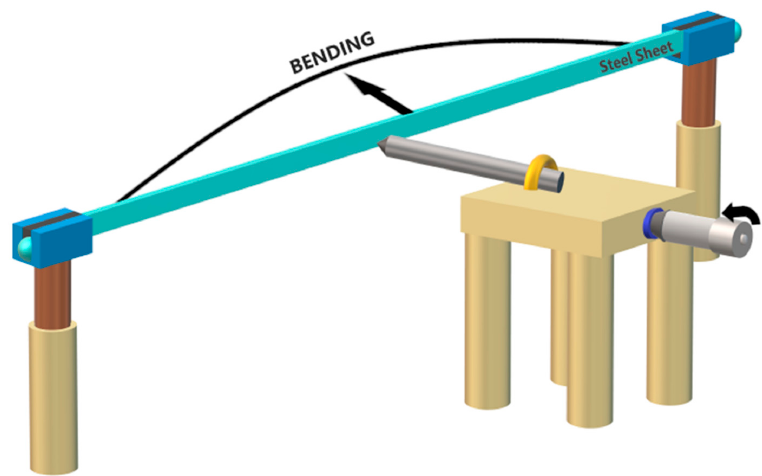
Figure 3. Schematic of the experimental setup for performing curvature measurements.